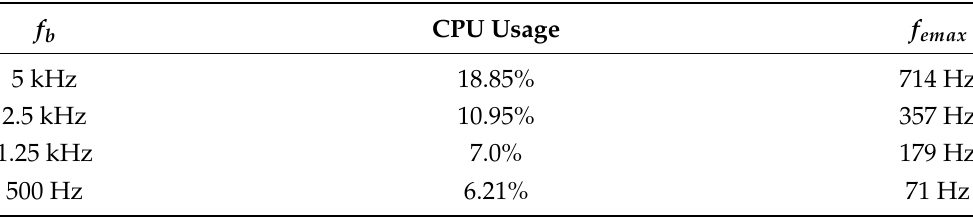
Table 4. Processor usages for executing EKF estimator with different background frequencies, f s = 5